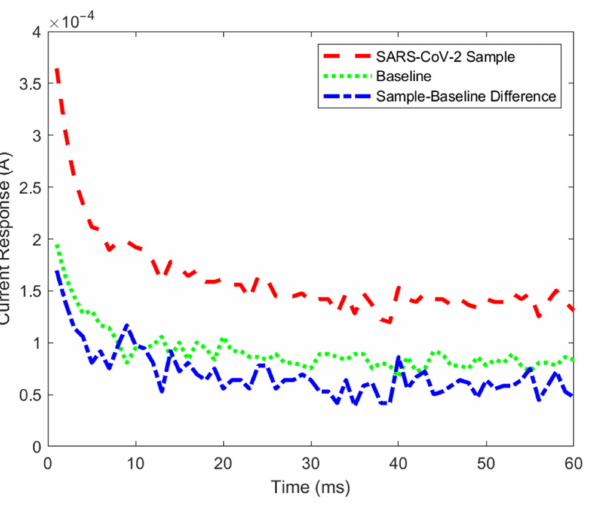
Figure 1. Example current response of a SARS-CoV-2 positive sample with 0.1 cp/mL concentration, baseline (true negative), and sample–baseline difference. The SARS-CoV-2 sample current response is higher than the baseline sample. Table 1. The dataset used for initial manual data analysis with 2% signature rule. Samples Vendor